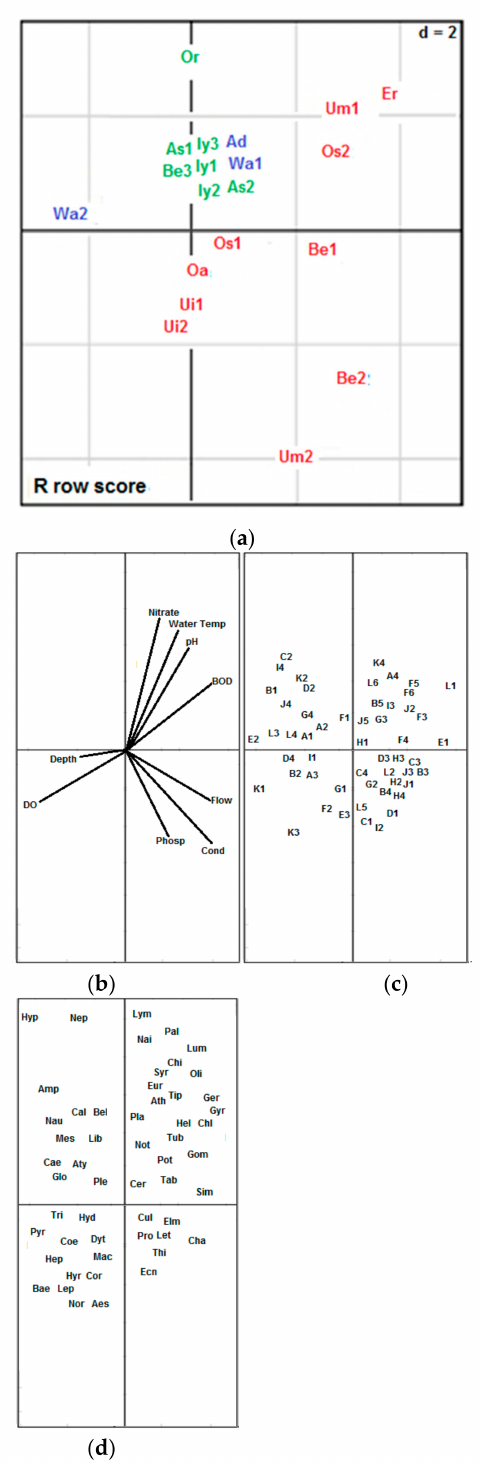
Figure 2. RLQ analysis showing the co-variation of the 20 river sites sampled in the present study (see Table 1 for site codes); sites in blue = LIS, sites in green = MIS and sites in red = HIS) ( a ), physico-chemical variables ( b ), macroinvertebrate traits ( c ), and macroinvertebrate taxa ( d ) in relation to the first two axes of the RLQ. Abbreviations: Water Temp = Water Temperature, Cond = Electrical conductivity, Flow = Flow velocity, Phosp = Phosphate, DO = Dissolved oxygen, BOD = Five-day biochemical oxygen demand (BOD 5 ). Site ecological classes: LIS = least impacted sites, MIS = moderately impacted sites, HIS = highly impacted sites. Traits: “A1 = Gills, A2 = Tegument / cutaneous, A3 = Aerial: